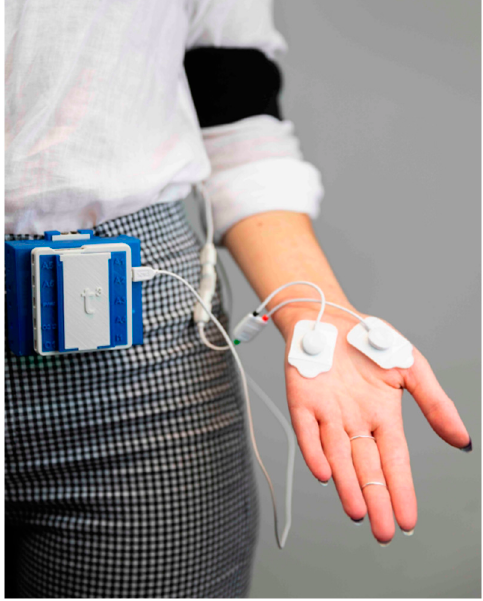
Figure 6. Electrodermal activity (EDA) sensors and the BITalino box.